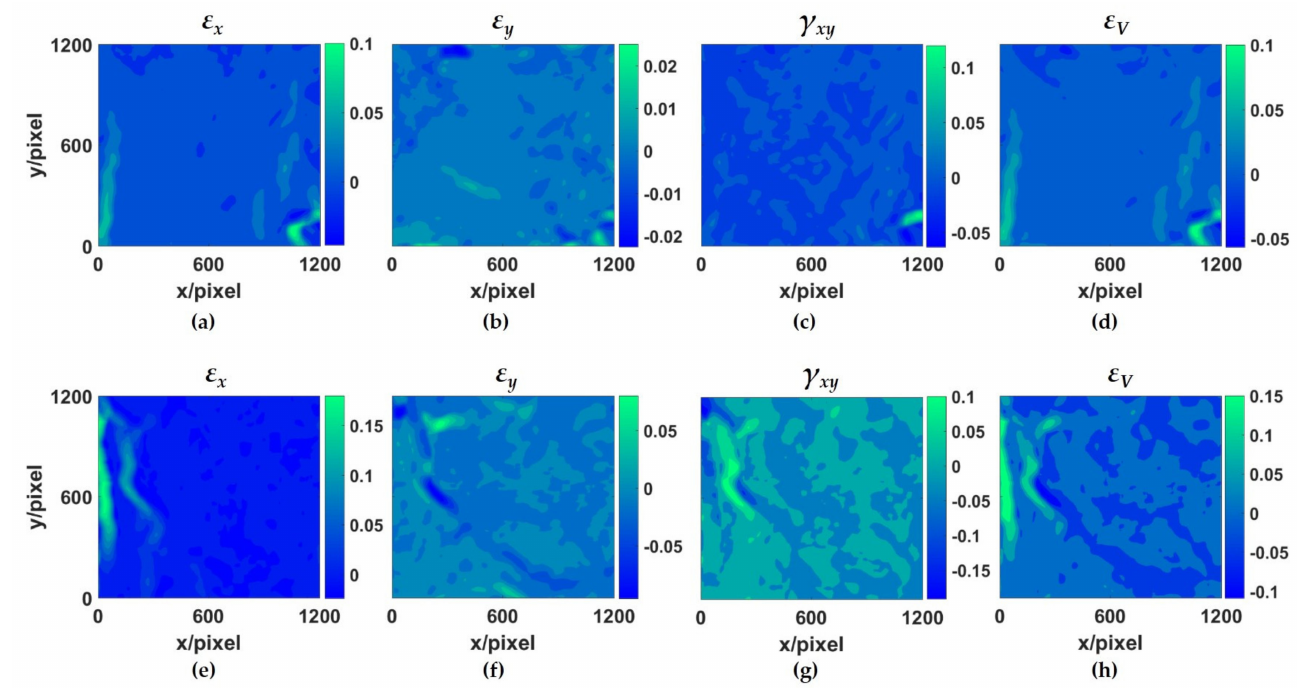
Figure 5. Normal strain ( ε x , ε y ), shear strain ( γ xy ) and volumetric strain ( ε V ) of OPC-based concretes at peak loads. ( a – d ) OPC-F; ( e – h )